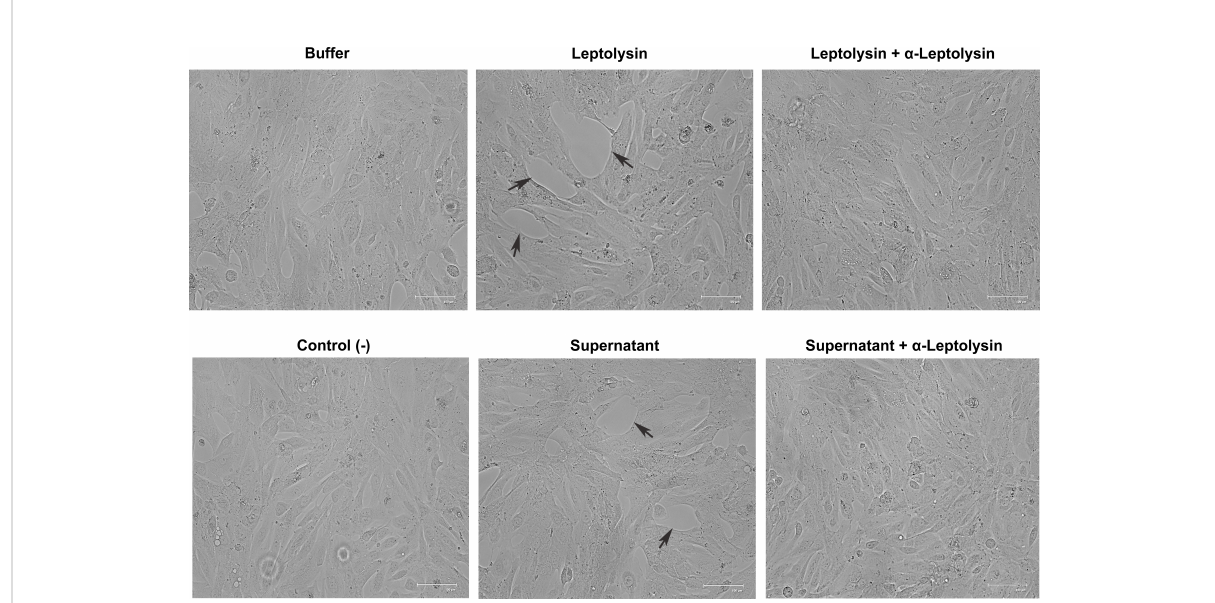
FIGURE 7 Morphological alterations induced by puri fi ed leptolysin and L. interrogans supernantant in renal cells. HK-2 cells were incubated for 24 h with leptolysin (0.5 µg) or Manilae L495 supernatant (5 µg) preincubated (or not) with leptolysin antiserum (1: 100). Negative controls included cells with culture medium (control -) and cells incubated with leptolysin buffer (buffer). Cells were visualized by light